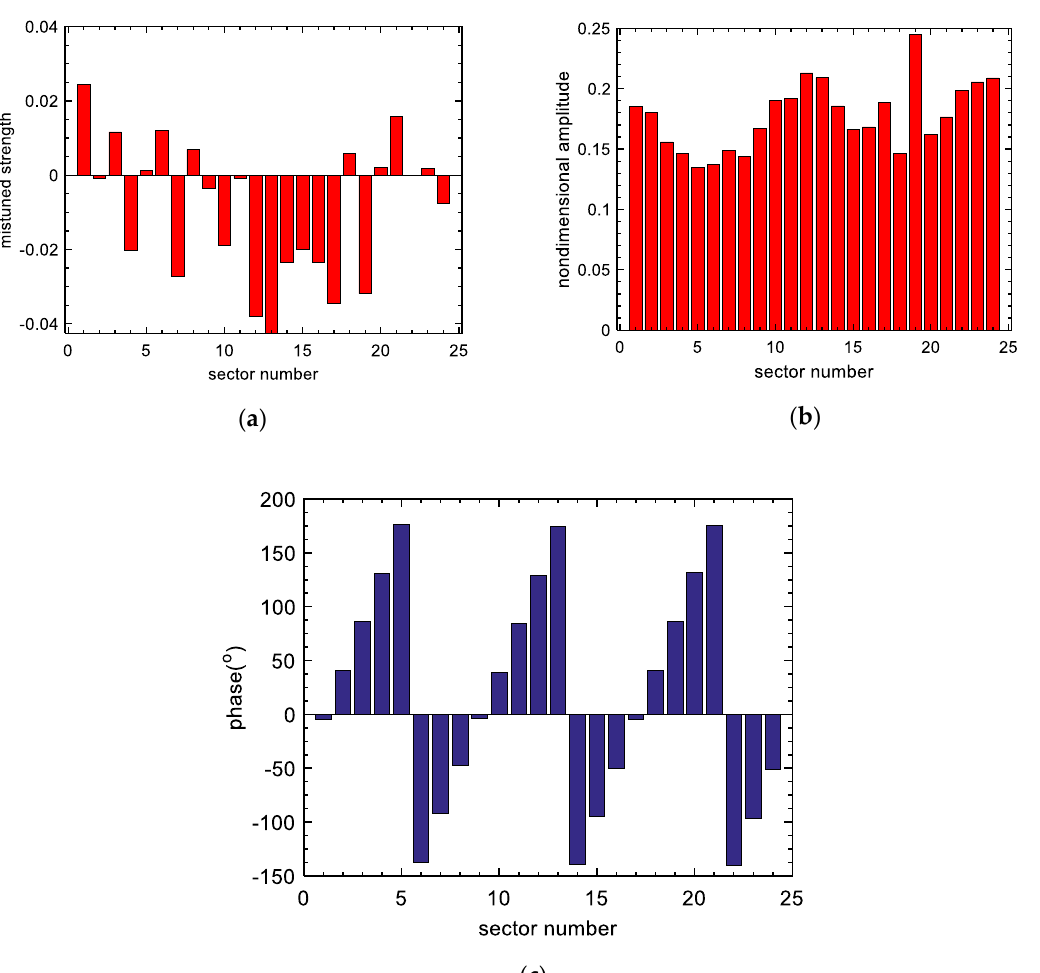
Figure 18. The targeted vibration problem of a bladed disk: ( a ) the mistuned pattern of the blade stiffness; ( b ) response amplitude of 24 blades without SSDI circuit (excited by engine-order E = 3); ( c ) the response phase of the 24 blades (excited by engine-order E = 3 at the same frequency as ( b )).